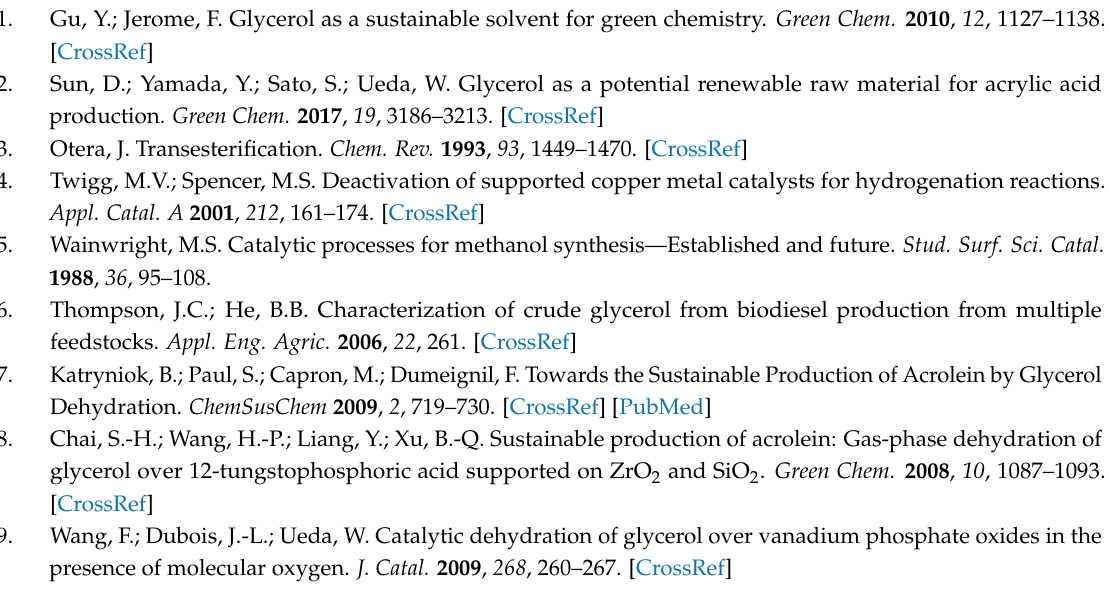
Figure S1: Nitrogen adsorption and desorption isotherms for ceria calcined at 400, 500, 600 and 700 ◦ C, Figure S2: LC-MS chromatogram corresponding to the post reaction solution of a reaction run over CeO 2 for 6 h. Table S1: Liquid and gas product list, Table S2: Influence of contact time on dilute glycerol reaction, Table S3: Influence of Table S5: Influence of CeO 2 calcination temperature on dilute glycerol reaction with GHSV ca. 3450 h − 1 , Table S6: The total carbon content (%) observed in a reaction over CeO 2 for 6 h at GHSV ca. 3600 h − 1